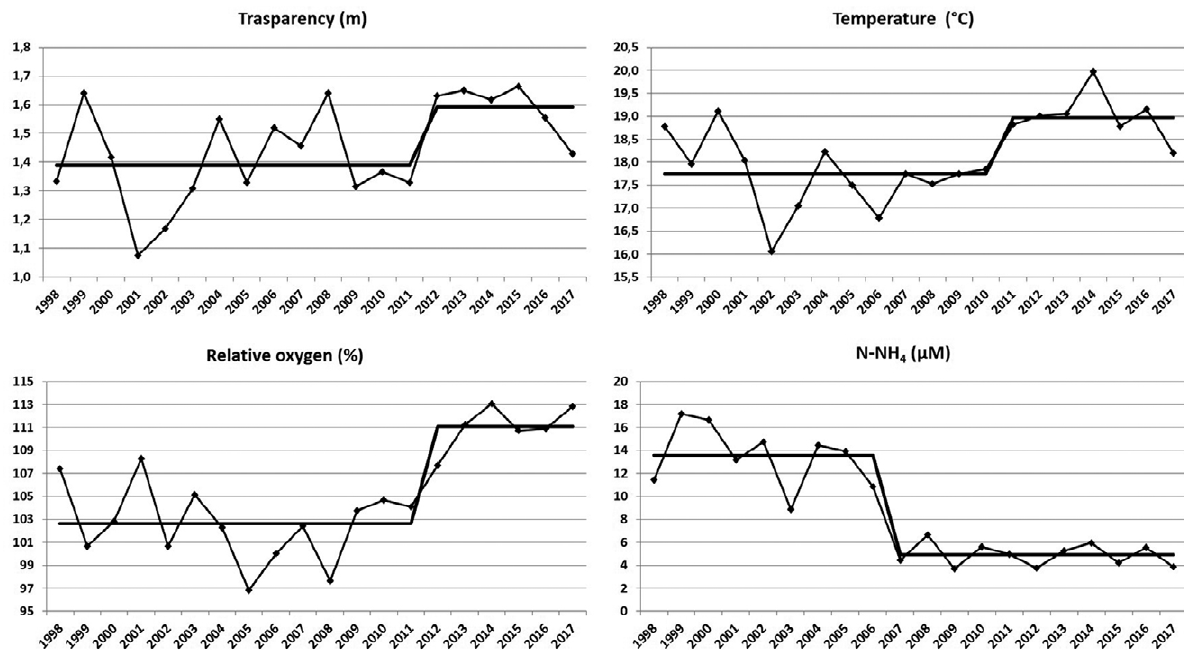
Fig. 4. – Time series of mean annual transparency, temperature, relative oxygen and ammonium in the sampling area. The thick line repre- sents the stepwise trend showing the regime shifts.